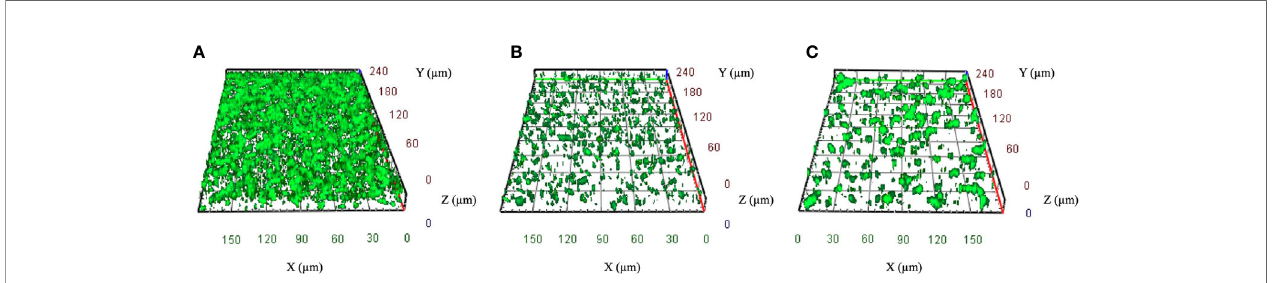
FIGURE 3 | Representative confocal microscopy images of CRKP bio fi lms developed on polystyrene slides for 24 h at 37°C. (A) Strong bio fi lm-producing non-HMV isolates. (B) Weak bio fi lm-producing non-HMV and (C) Weak bio fi lm-producing HMV strain. Orthogonal sections displaying horizontal (z) and side views (x and y) of reconstructed 3D bio fi lm images are shown.